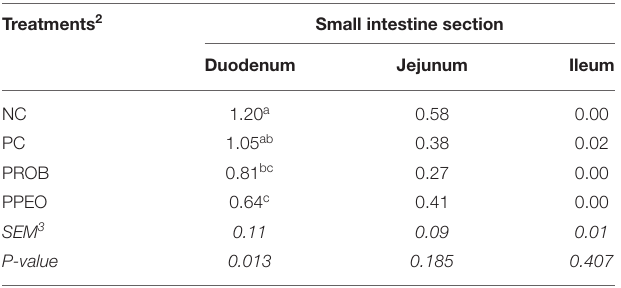
TABLE 4 | Effect of dietary probiotic (PROB) or probiotic/prebiotic/essential oil (PPEO) supplementation on intestinal lesion scores of broiler chickens under a naturally occurring subclinical necrotic enteritis challenge 1